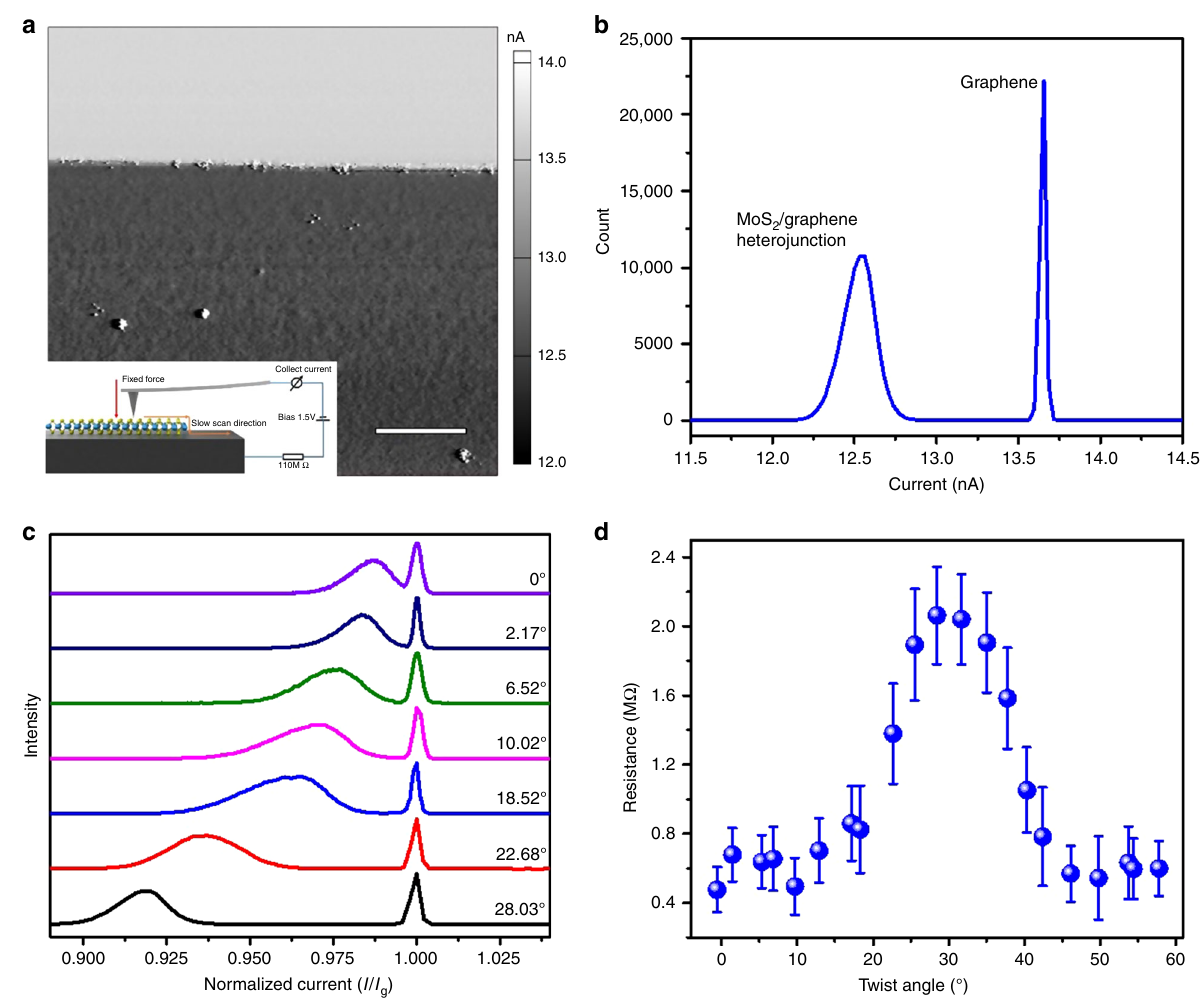
Fig. 3 Twist-angle-dependent conductivities of MoS 2 /Gr heterojunctions. a A typical current mapping of a MoS 2 /Gr heterojunction with a twist angle of ∼ 28.03°, scale bar, 100 nm. Bright and dark areas in this mapping re fl ect the tip-to-sample current through the bare graphene and heterojunction, respectively. Inset is the experimental setup for current mapping. b Statistical chart derived from a . c Normalized current distributions of seven heterojunctions with different twist angles. d Statistic resistances of MoS 2 /Gr heterojunctions with different twist angles. Error bar is derived from the full width at half maximum of the MoS 2 peaks, etch statistics contains at least 20,000